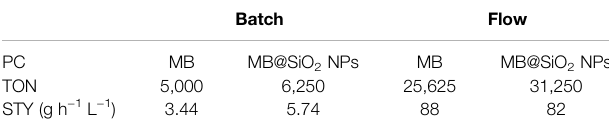
TABLE 2| Summaryofstabilityand productivityvaluesobtainedinbatchand fl ow